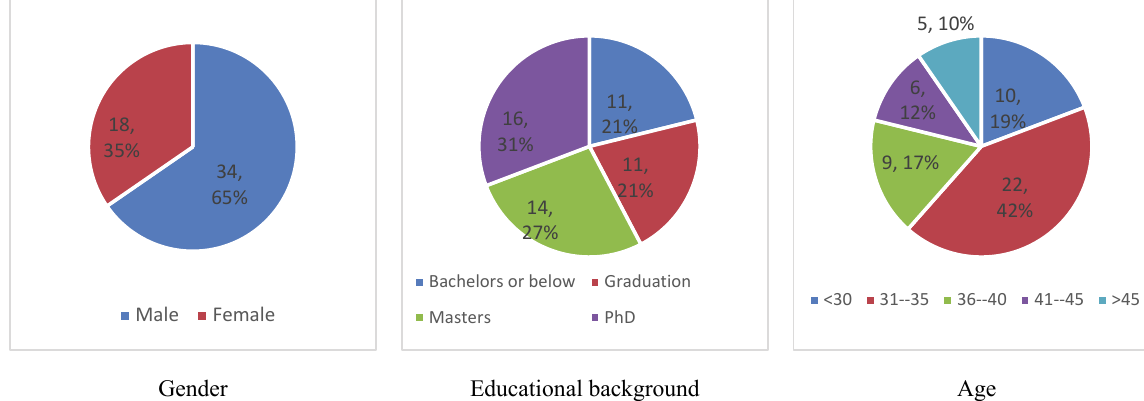
Fig. 2. Demographical data of the study respondents